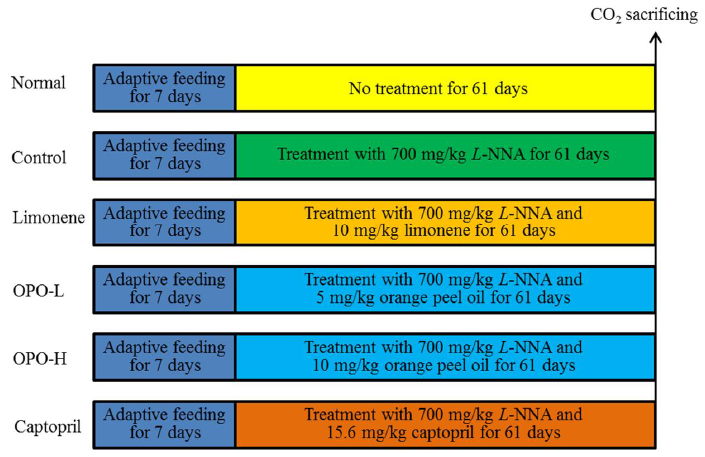
Figure 1. The process of animal experiment. L -NNA, N ω -nitro- L -arginine.